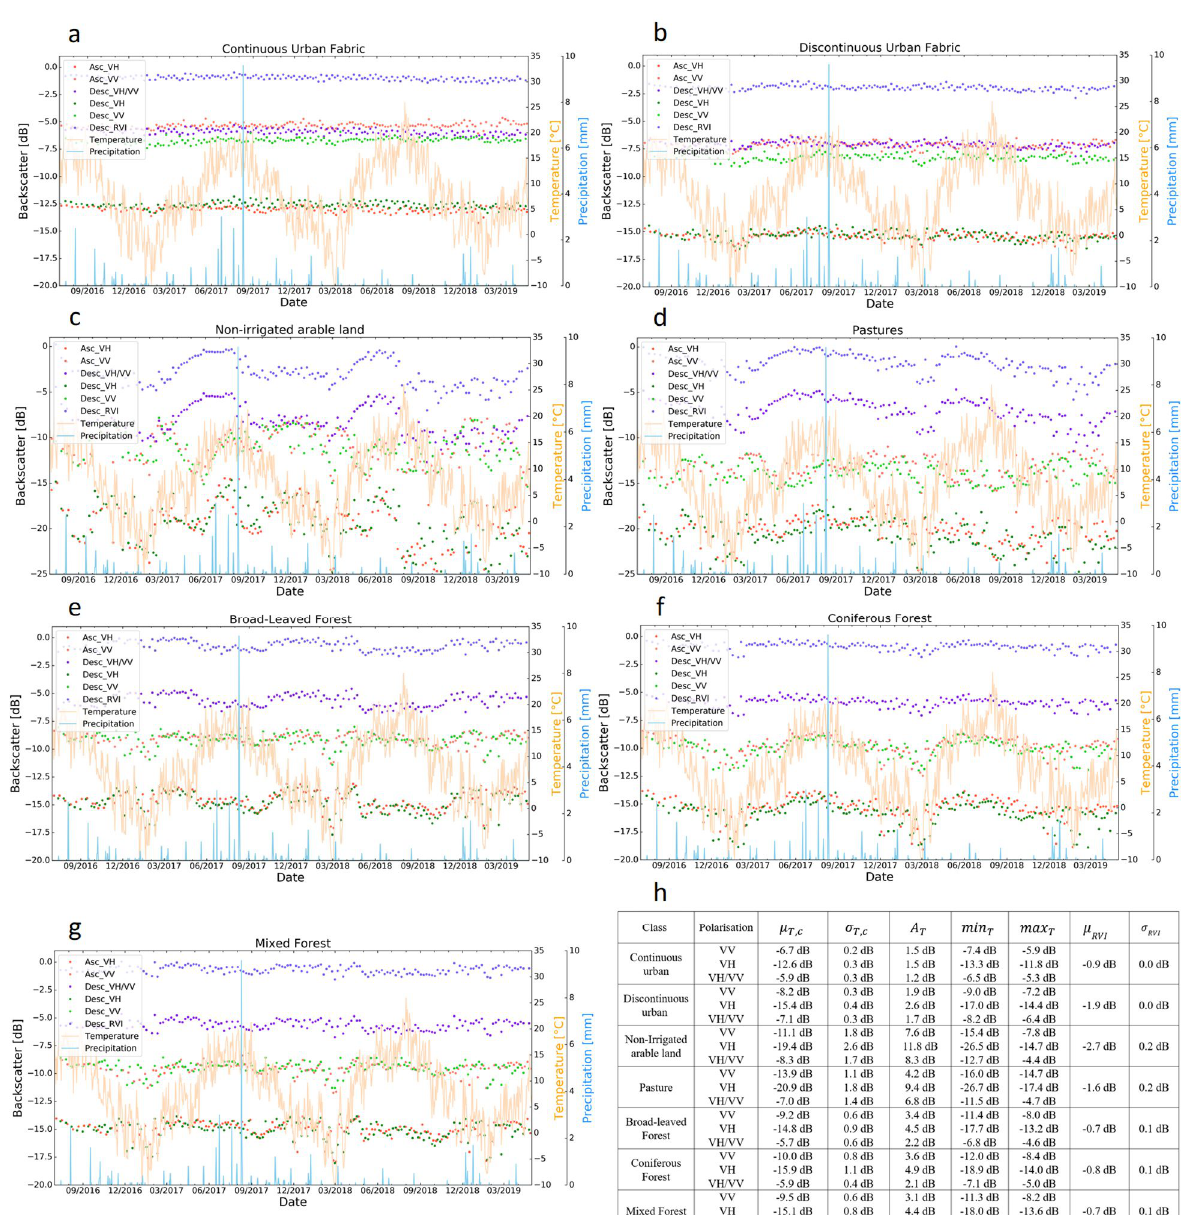
Figure 3: Time series profiles of Sentinel-1 C-band backscatter values and meteorological conditions for CORINE land cover classes of Thuringia: a) continuous urban fabric; b) discontinuous urban fabric; c) non-irrigated arable land; d) pastures; e) broad- leaved forest; f) coniferous forest; g) mixed forest; h) principal multi-temporal metrics for the descending